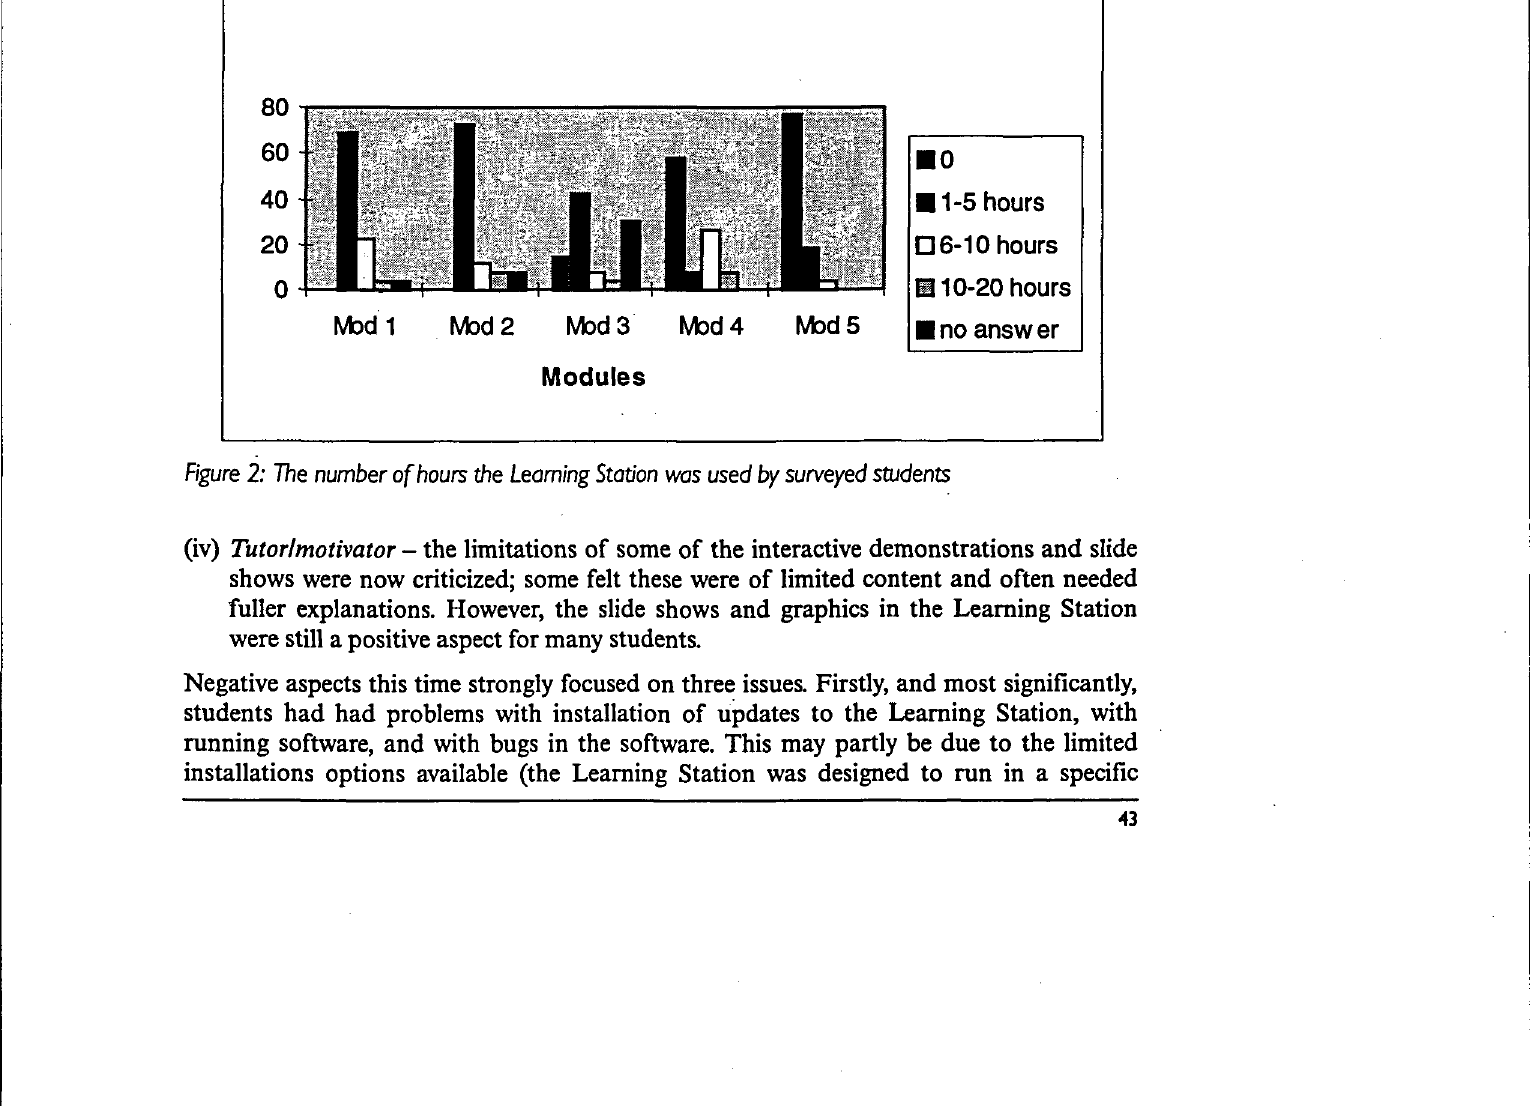
Figure /: The number of times trie Learning Station was used by surveyed students